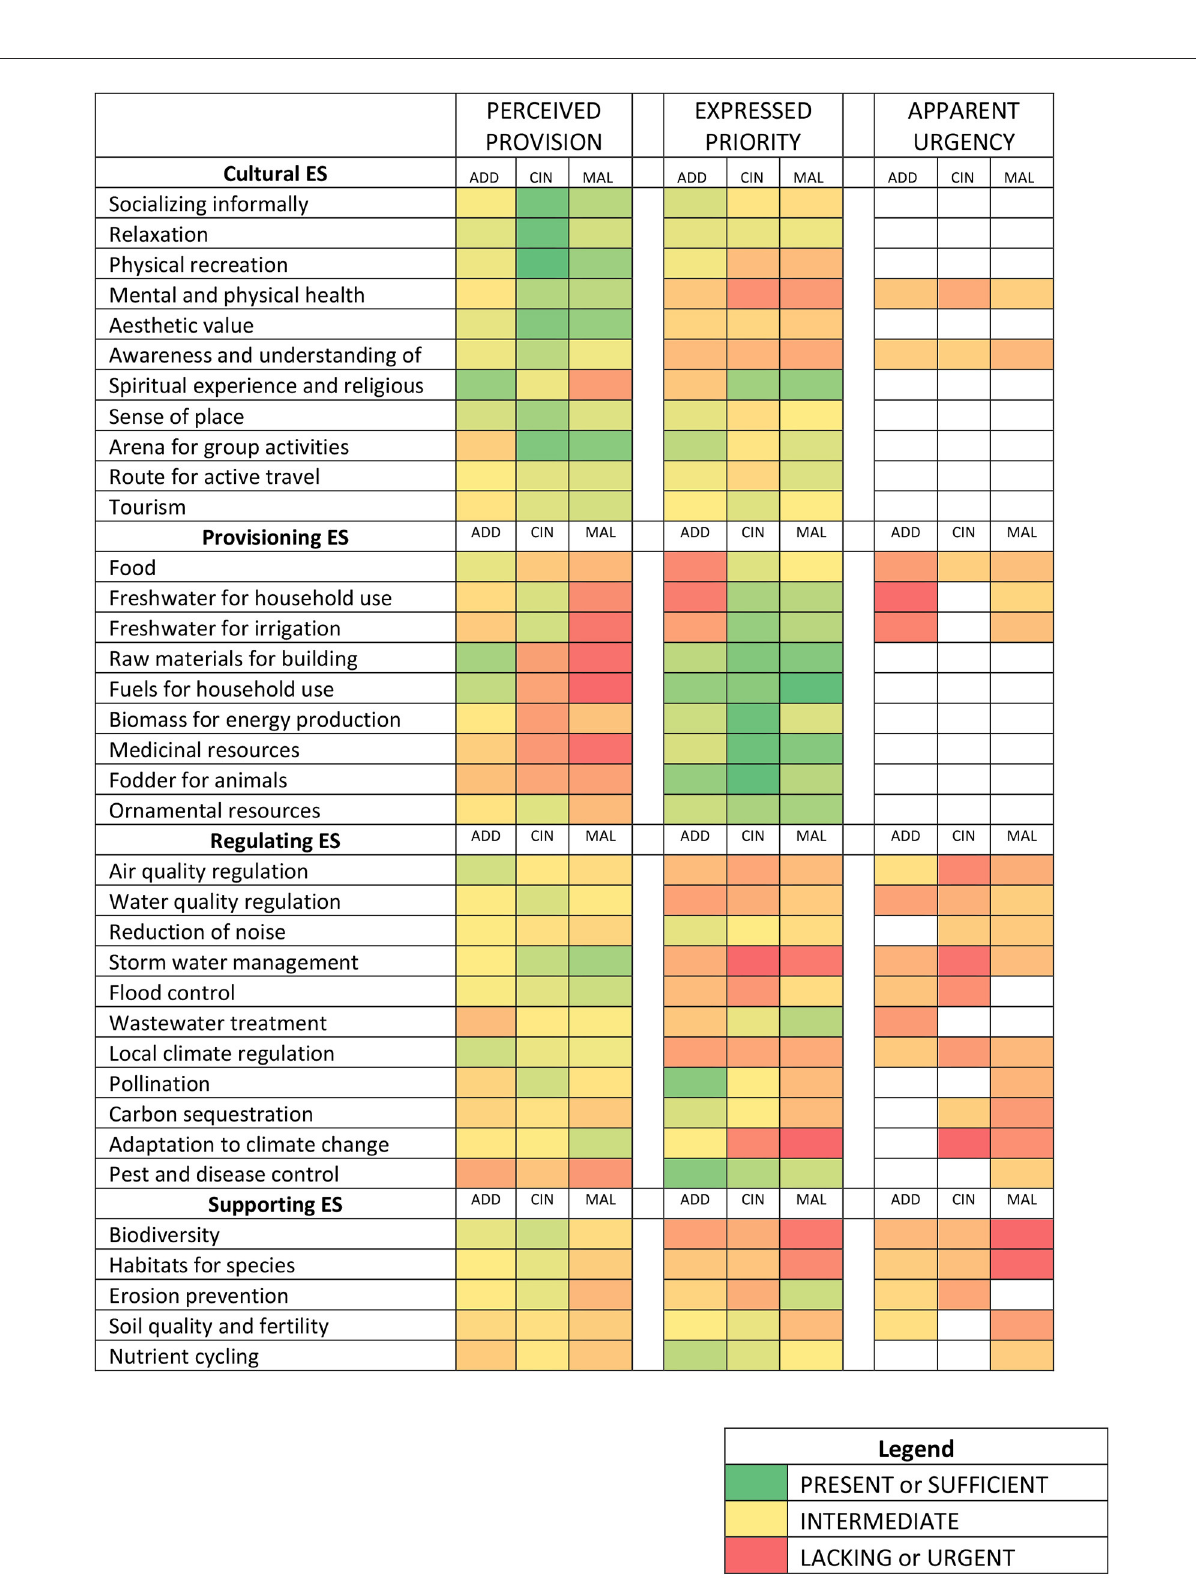
FIGURE3 Expert stakeholder assessments of current provision and future priority for 36 ecosystem services (ES) from UGI in Addis Ababa, Ethiopia (ADD), Cincinnati, USA (CIN) and Malmö Sweden (MAL); plus a calculation of apparent urgency as the normalized difference between provision and priority. Apparent urgency highlights those ES for whom future priority is higher than perceived current provision, with a difference > 10% of the potential